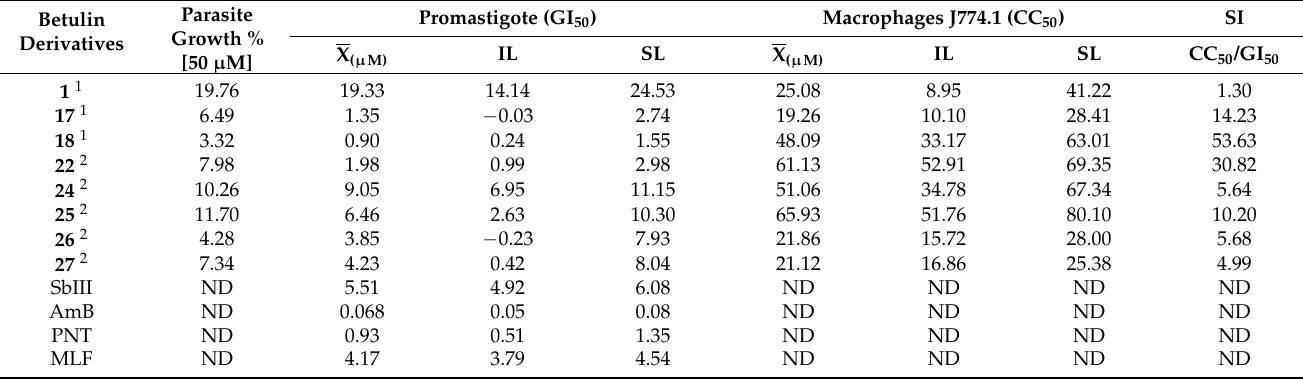
Table 1. In vitro activity, toxicity, and selectivity indices of the best betulin derivatives against the reference strain LTB0016. Parasite Betulin Growth Derivatives